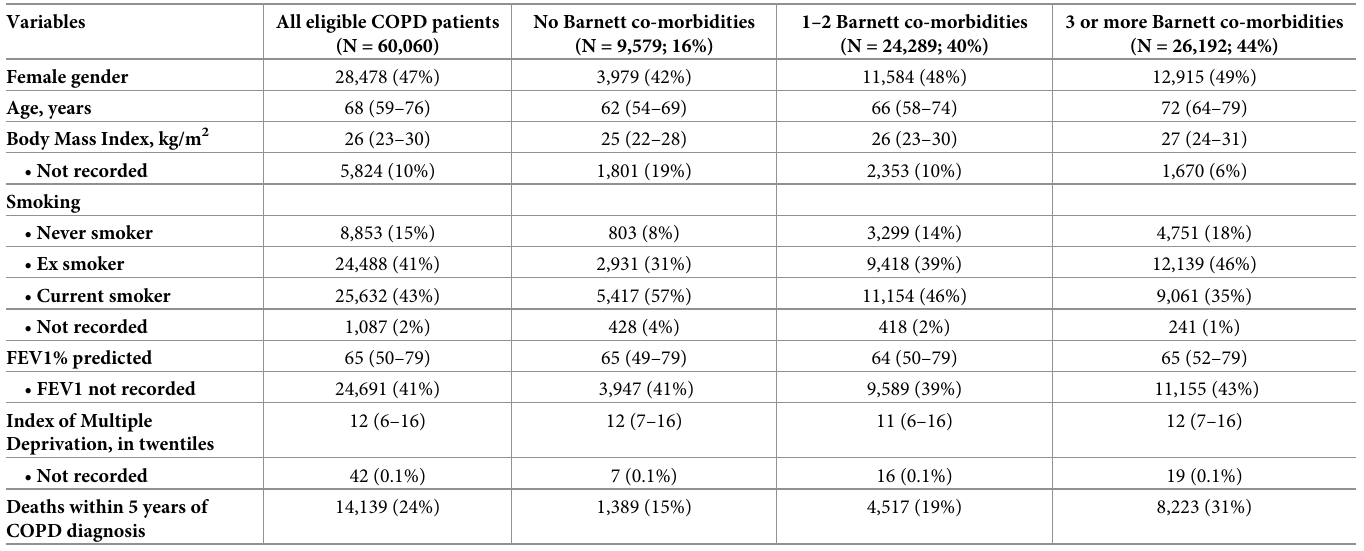
Table 1. Demographics and clinical characteristics of the linked group (those linked to hospital and ONS mortality data).